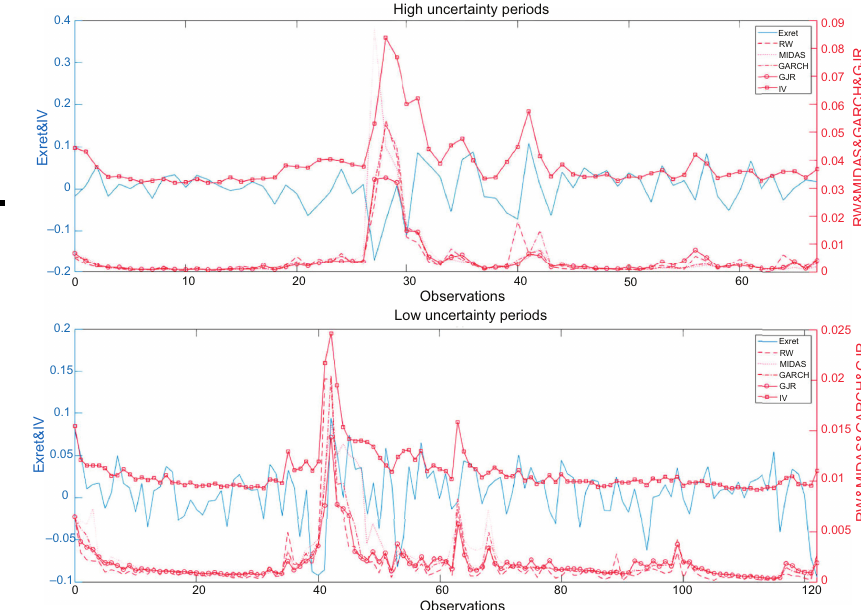
Figure 2. Note(s): This figure plots the time-series of monthly excess stock market returns, Time-series of monthly excess stock market returns, conditional (i.e., FVOV t ≤ 0) uncertainty periods. The left scale presents excess stock market variances and implied variance with